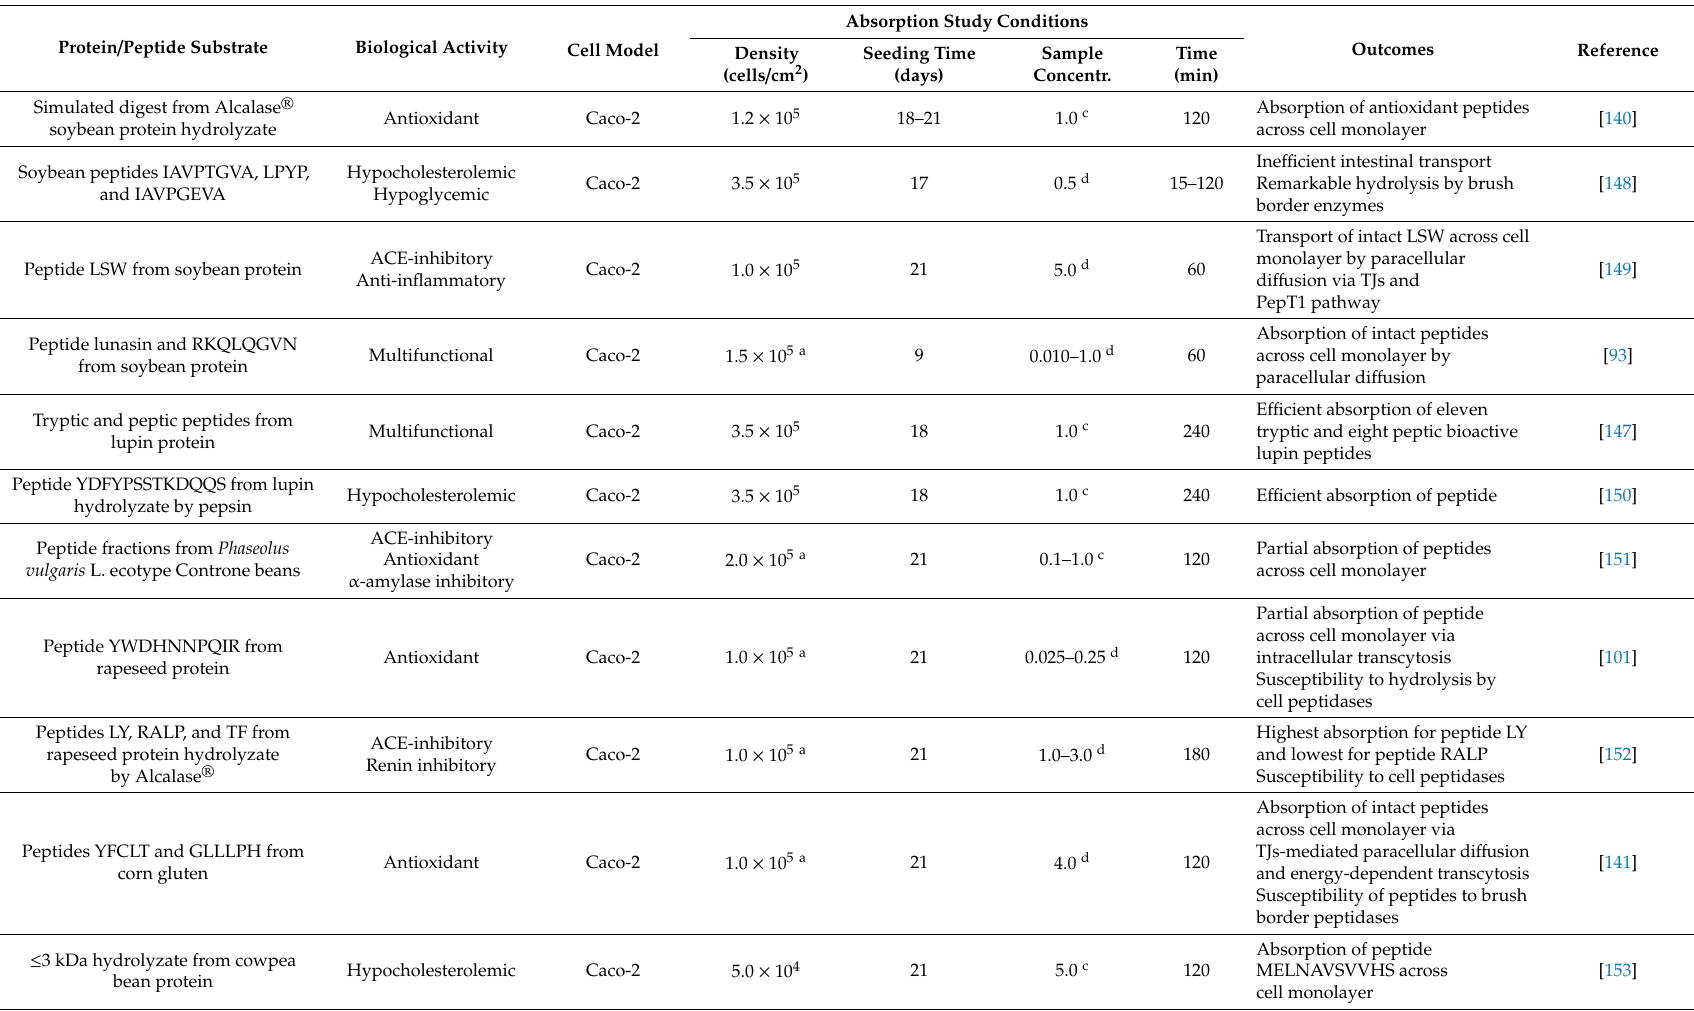
Table 2. Recent studies on cell models used to evaluate the absorption of food bioactive